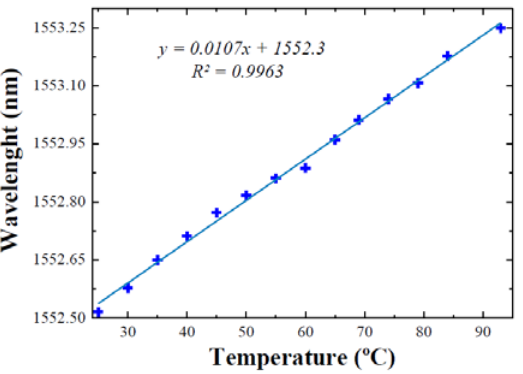
Figure 10. Temperature sensitivity of the EDSCL. The whole EDSCL sensor exhibits the same sensitivity as the FBG employed to select the lasing wavelength.